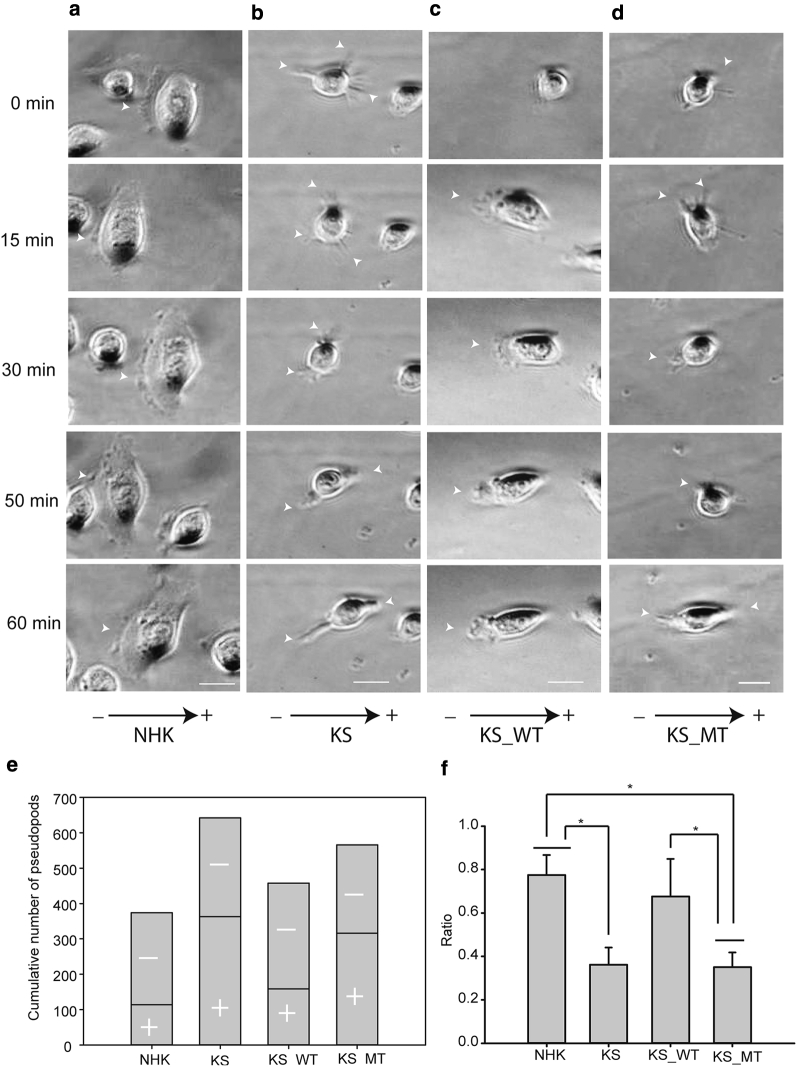
Kindlin-1 is required for protrusion polarization in electrotaxis. (a–d) Representative time-lapse images showing pseudopod formation and localization over 1 hour in EF (200 mV/mm) stimulation of (a) NHK, (b) KS, (c) KS_WT, and (d) KS_MT cells (see Supplementary Video S3). The EF vector is horizontal, with cathode to the left. The arrowheads indicate pseudopods. (e) Cumulative number of pseudopods of cells in a–d over EF stimulation. Upper rectangle indicates the number of cathode-directed pseudopods; lower rectangle indicates anode-directed pseudopods. (f) The ratio of cathodal pseudopods against all protrusions was analyzed. Results are presented as means ± standard error of the mean, n ≥ 3 experiments. ∗P < 0.05. Scale bar = 50 μm. min, minutes; KS, Kindler syndrome; KS_MT, kindlin-1–mCherryW612A point mutation; KS_WT, Kindler syndrome cells infected with wild-type kindlin-1–mCherry; NHK, normal human keratinocyte.